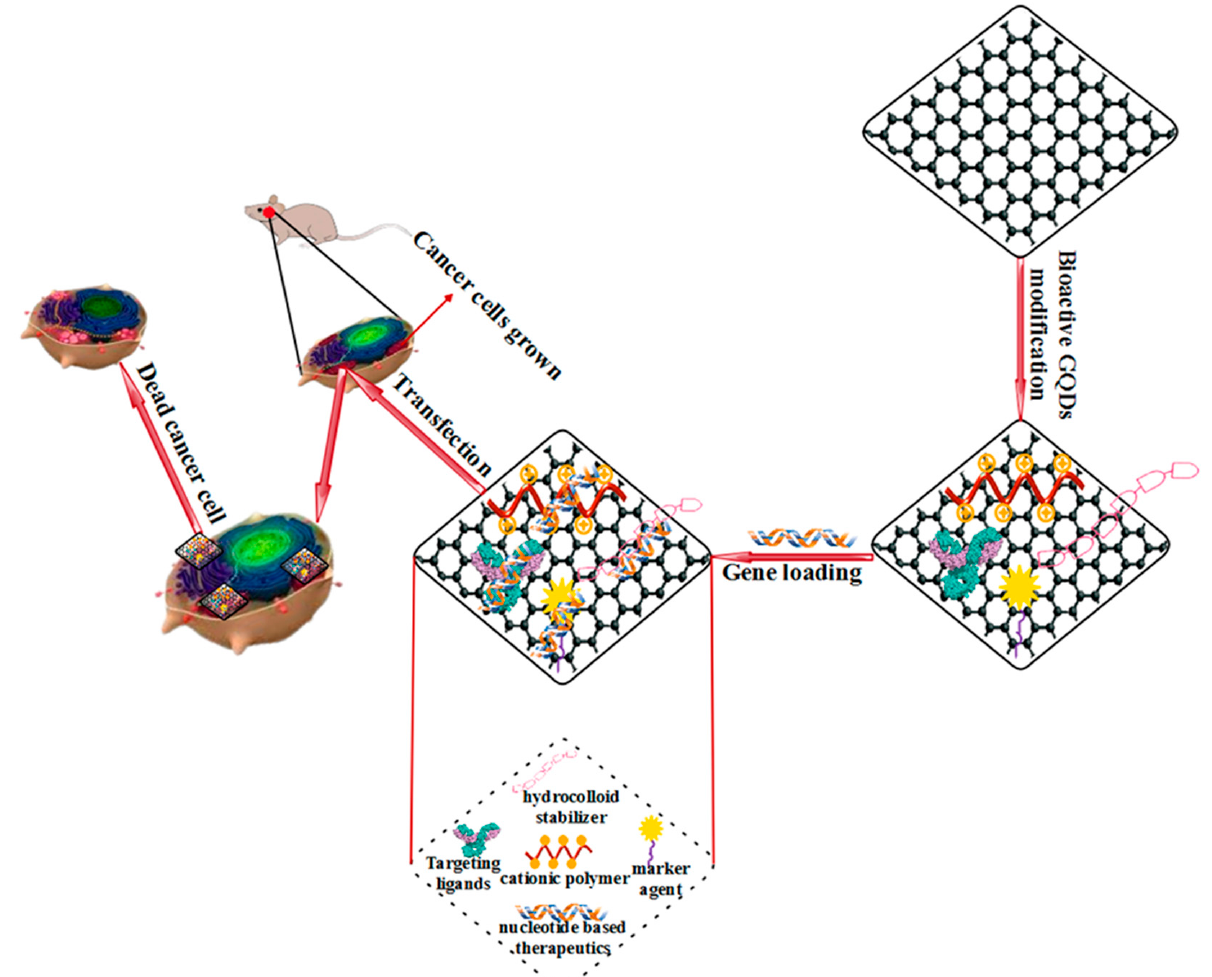
Figure 8. Treatment of cancer cells with gene therapy based on bioactive GQDs.